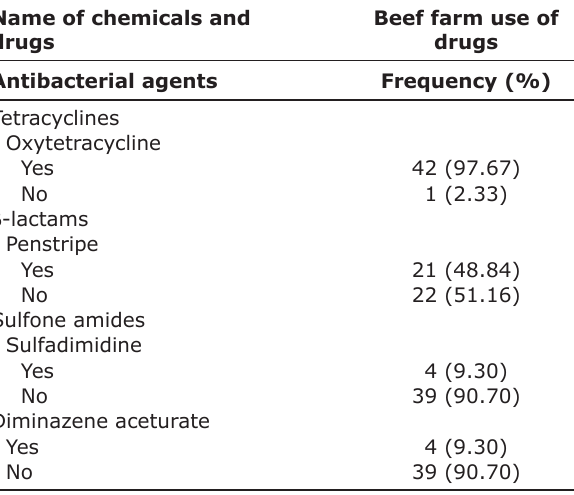
Table-2: Antimicrobial drugs used in selected beef